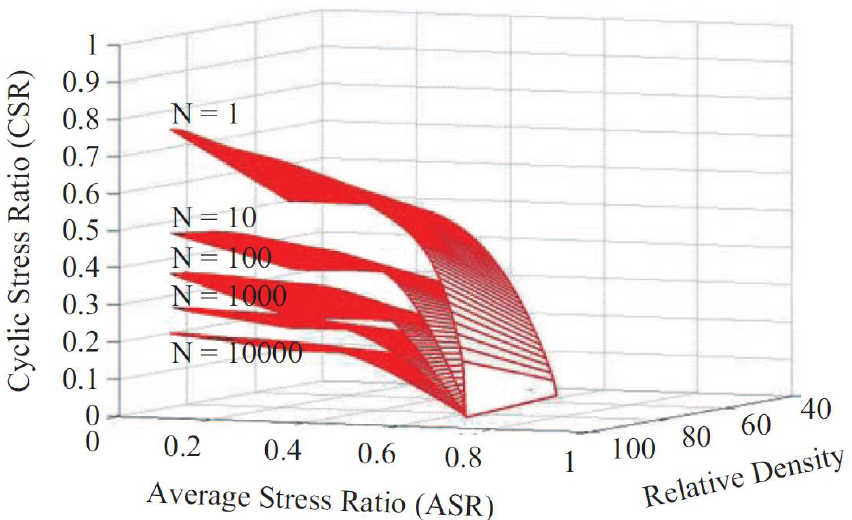
Figure 8. Three-dimensional criterion lines for marine silty sand showing CSR, ASR, and Dr, and the corresponding cyclic and permanent shear strains at failure (adapted from [21]).